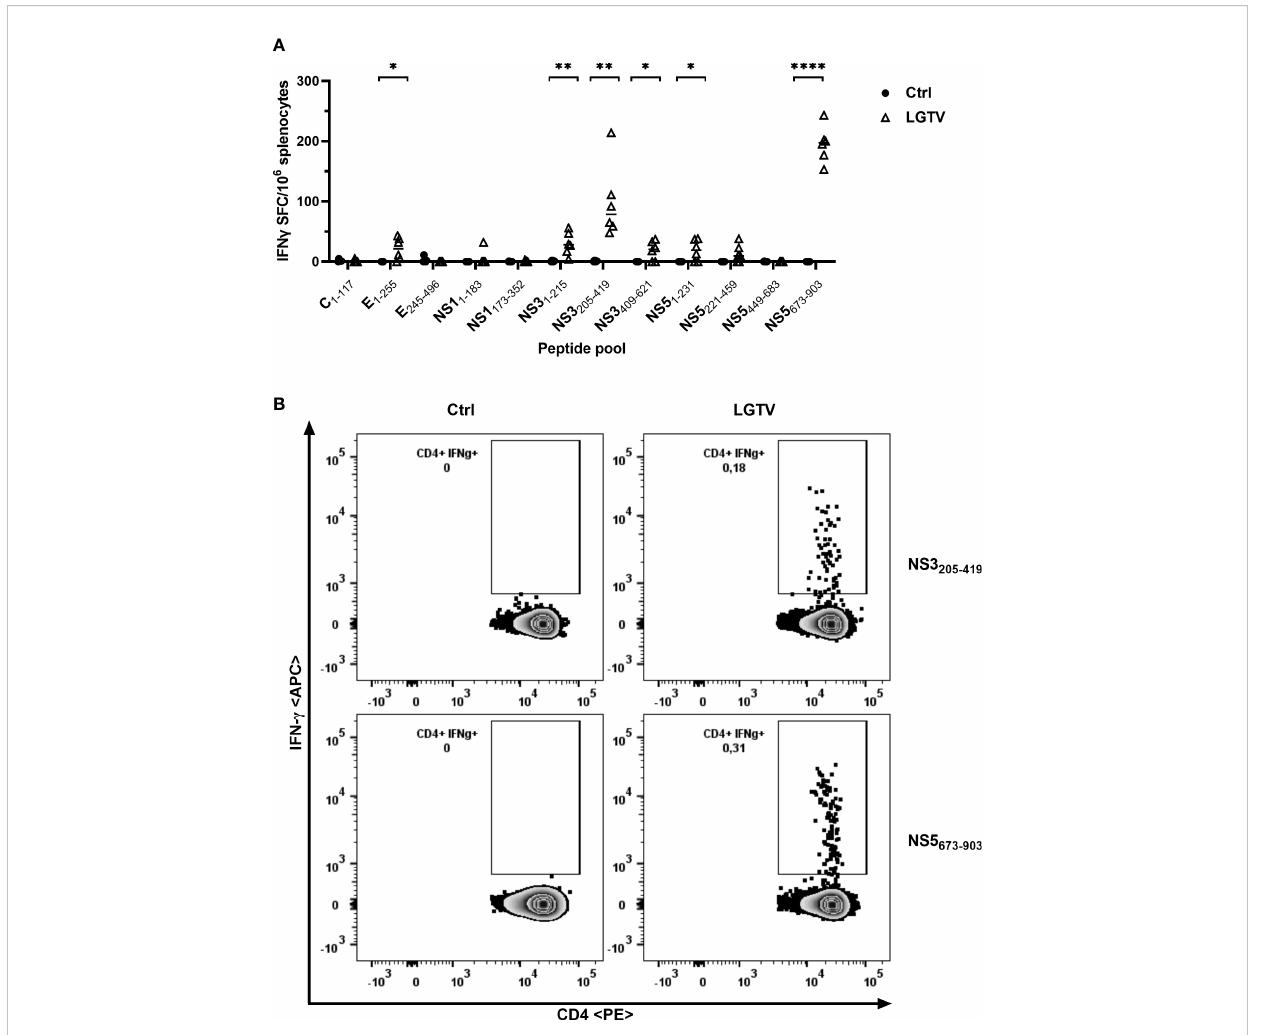
FIGURE 2 T cells induced by LGTV cross-react with TBEV antigenic peptides. (A) Splenocytes collected from control ( (cid:129) ) or LGTV ( D ) infected mice (n=6) were restimulated with TBEV-speci fi c peptide pools and the frequency of IFN- g producing cells were determined using IFN- g ELISpot assay. For statistical analysis, unpaired t-test was used (E 1-255 : p = 0.0168; NS3 1-215 : p = 0.0038; NS3 205-419 : p = 0.003; NS3 409-621 : p = 0.0178; NS5 1-231 : p = 0.023; NS5 673-903 : p <0.0001) and the median is shown. (B) Flow cytometric analysis of splenocytes restimulated with TBEV peptide pools. Representative FACS plots gated on live CD3 + CD4 + T cells show IFN- g in LGTV infected mice in response to TBEV NS3 205-419 and NS5 673-903 peptide pool restimulation. *p<0.05, **p<0.01 and